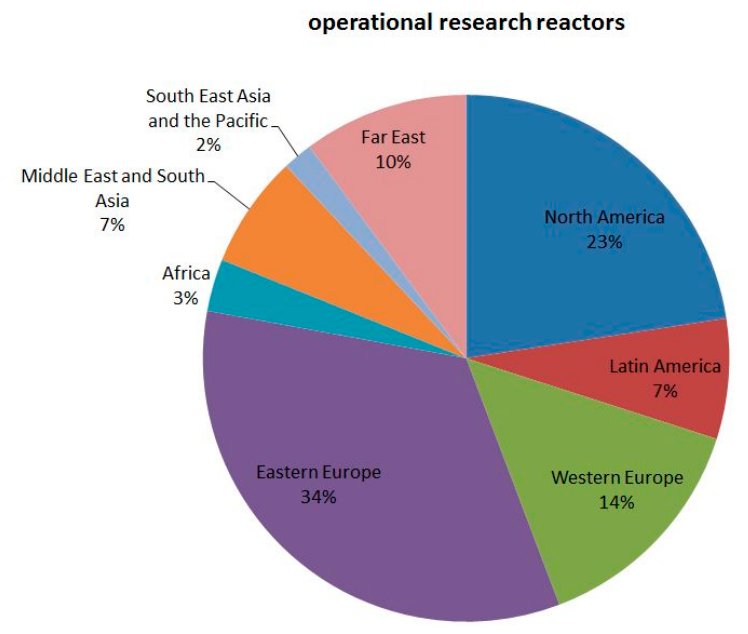
Figure 5. Distribution of the 217 operational research reactors in the different global regions.